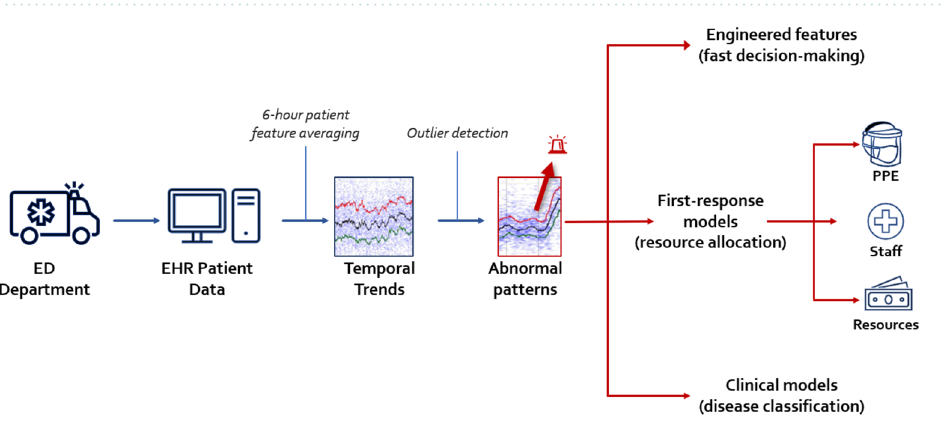
Figure 8. Population surveillance model: major